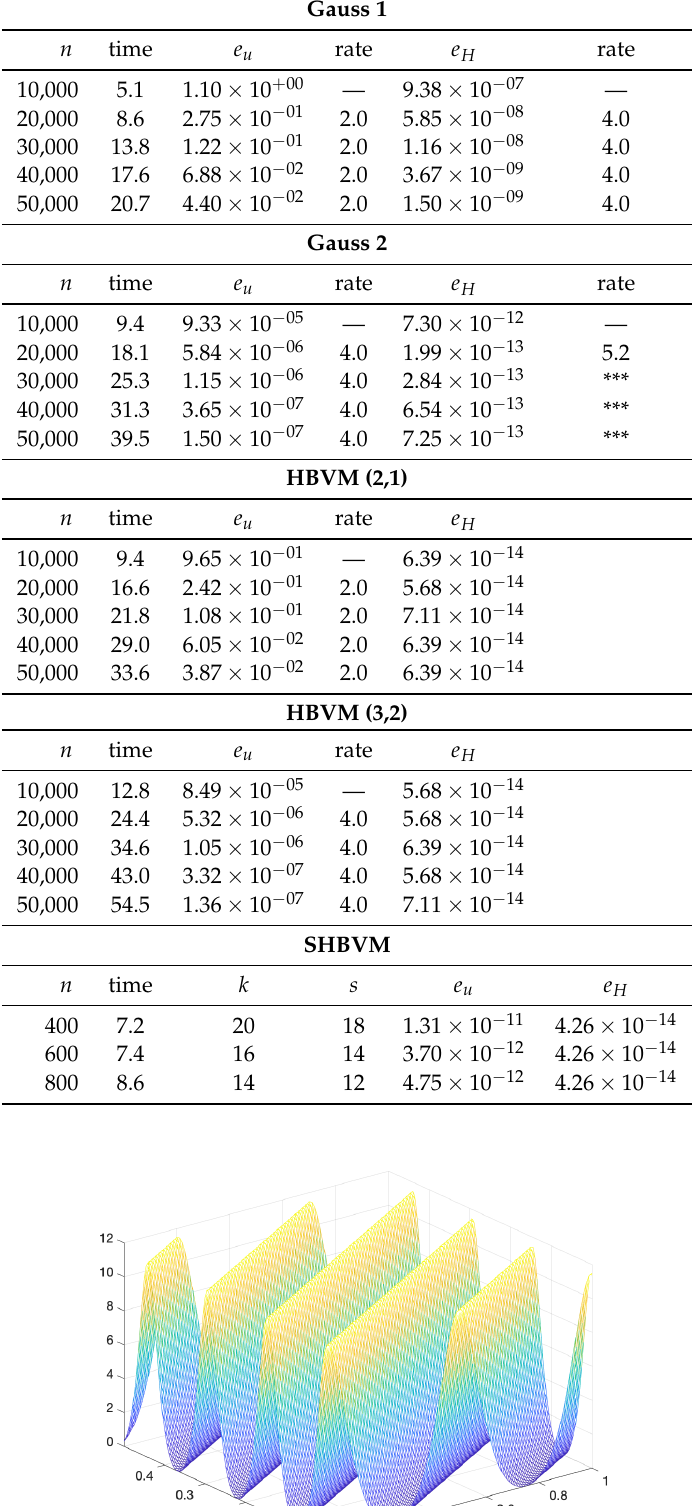
Table 3. Numerical solution of the Korteweg-de Vries Equation (96) using a time-step h = 10/ n